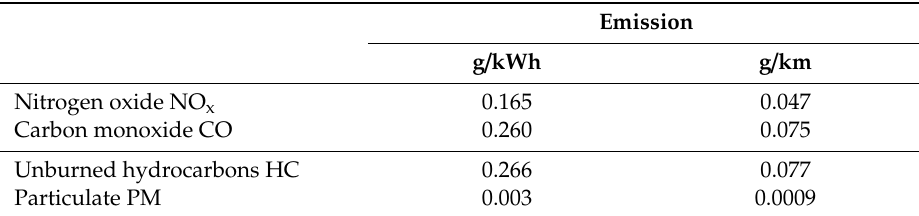
Table 31. Polluting emission of selected MGT.